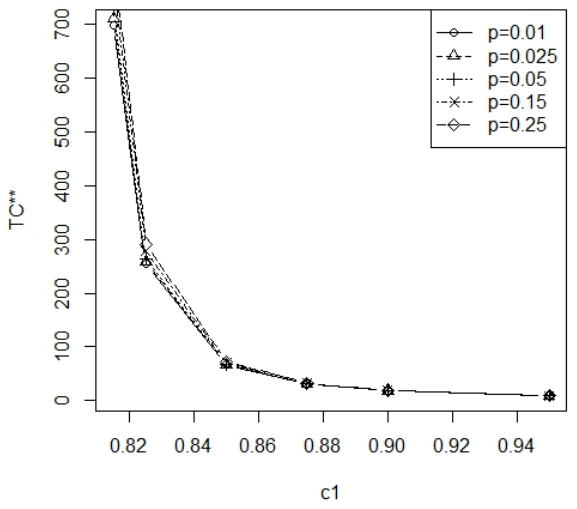
Figure 9. The minimum total cost curve for p = 0.01, 0.025, 0.05.